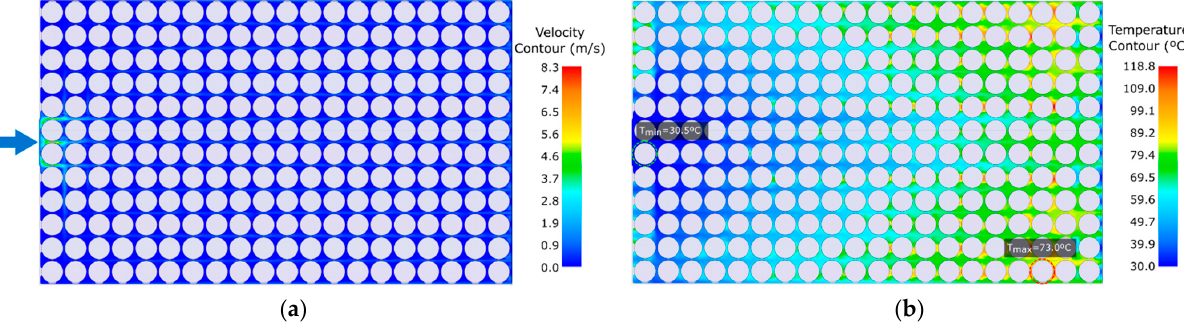
Figure 3. The contour of ( a ) velocity and ( b ) temperature of 1 inlet model.